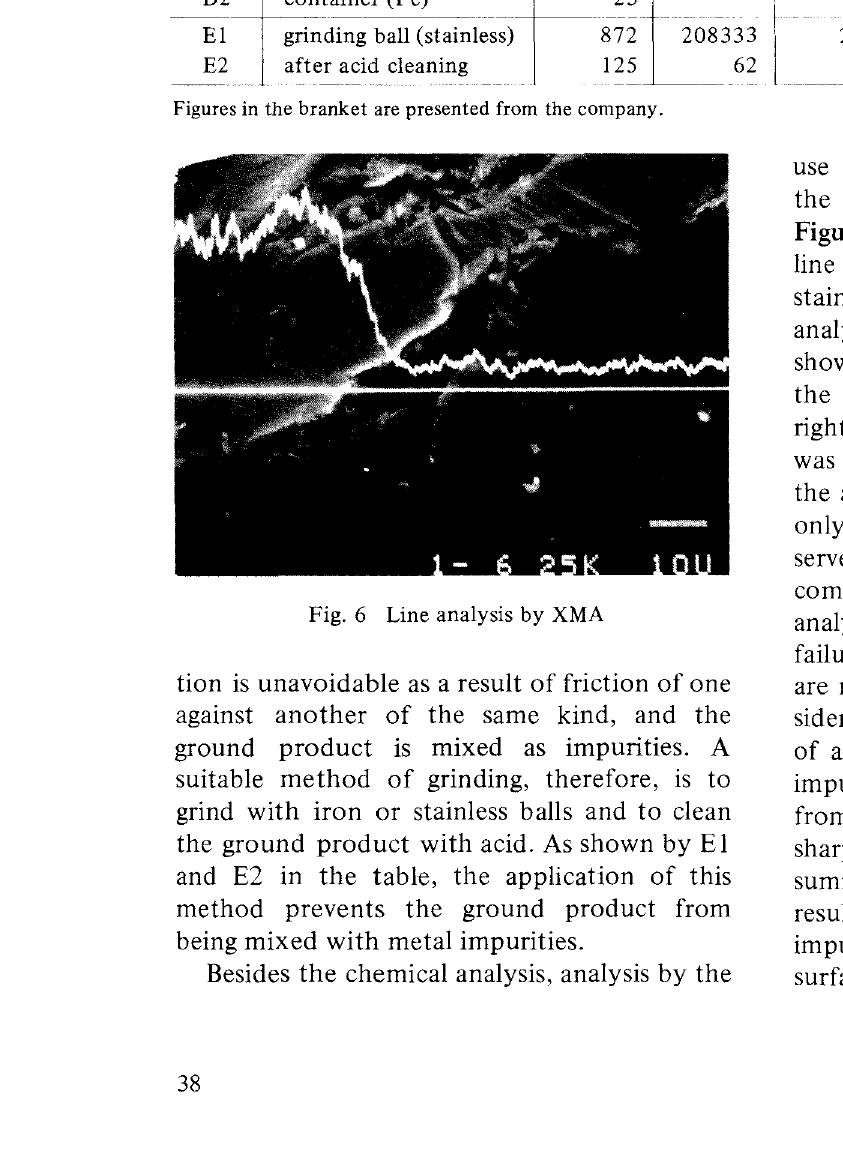
Fig. 6 Line analysis by